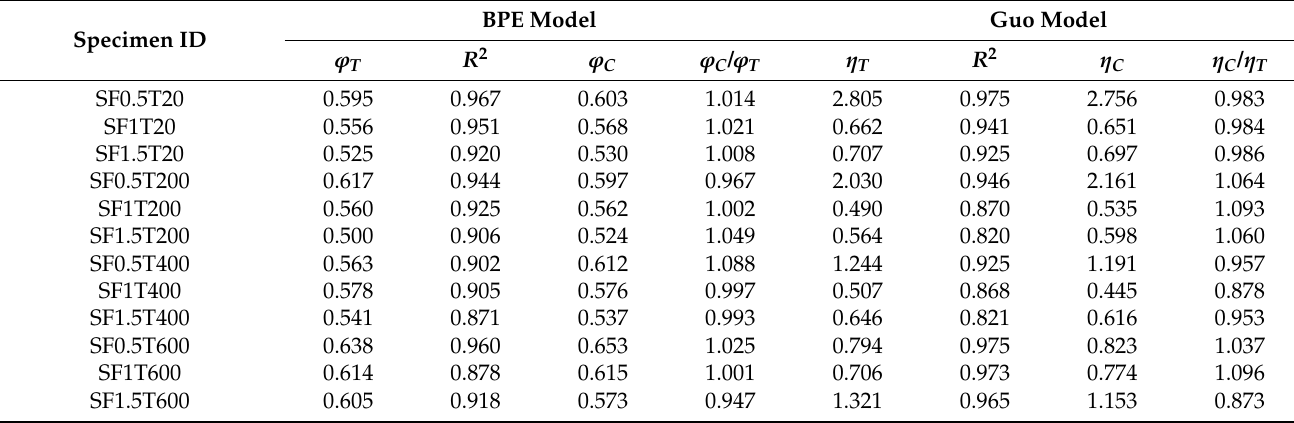
Table 6. Fitted model